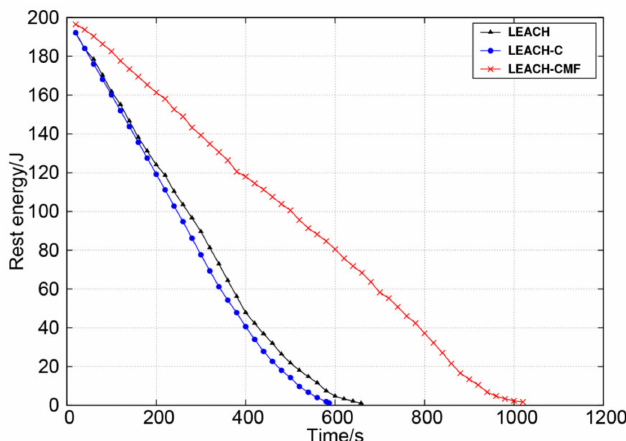
Figure 10. Change of total residual energy over